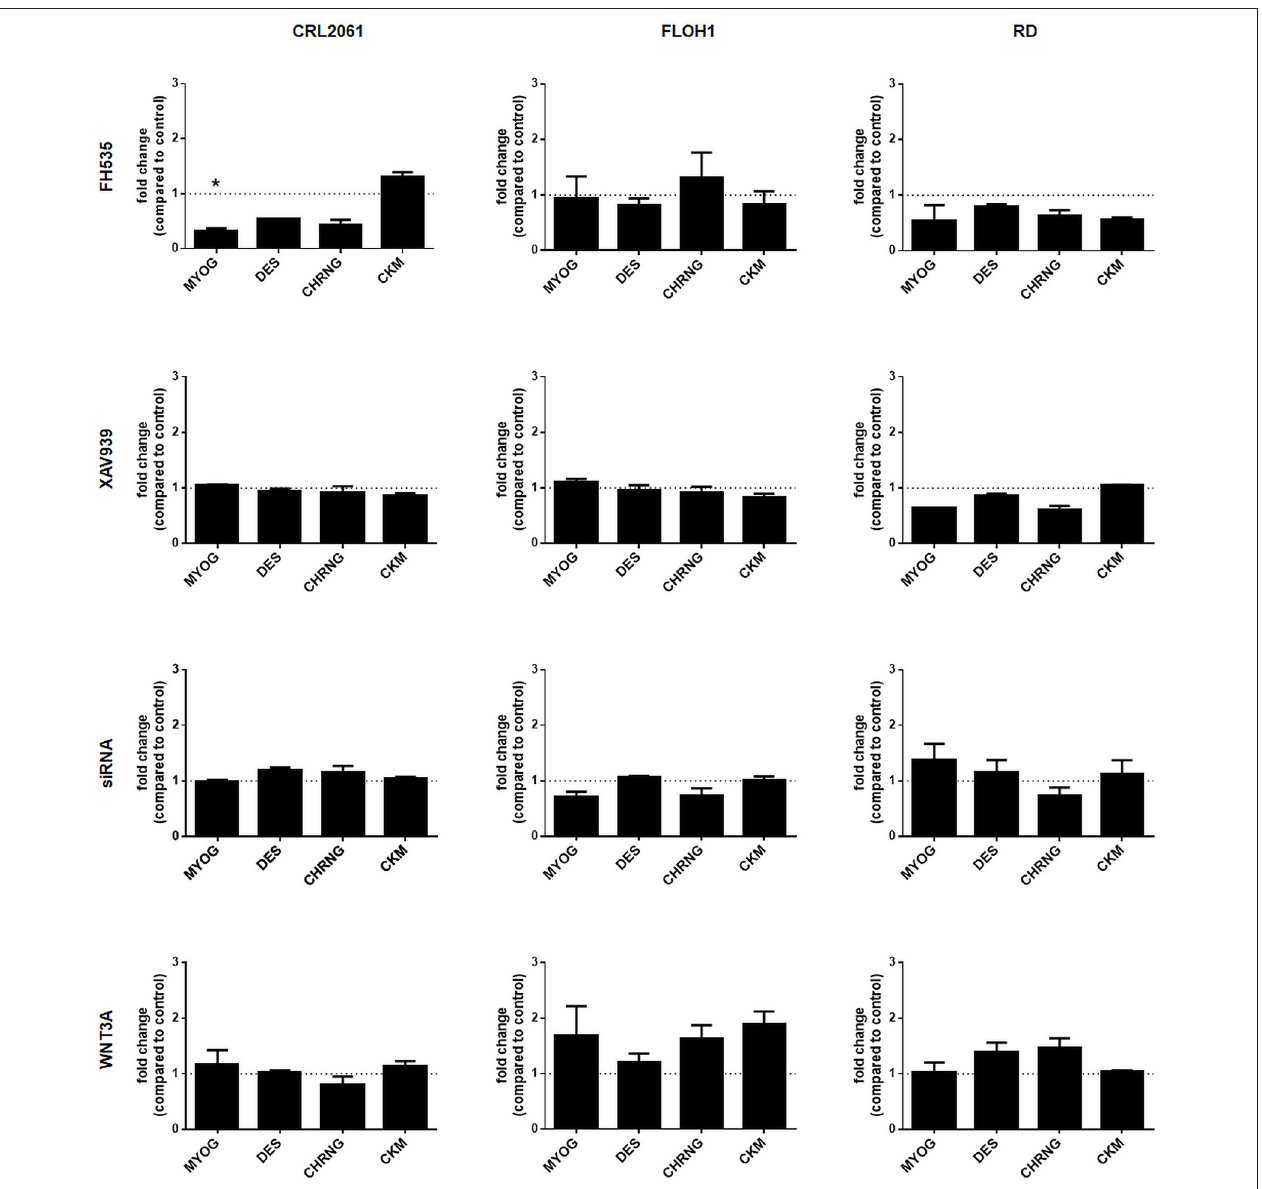
FIGURE 7 | Effects of FH535, XAV939, ß-catenin-siRNA, or WNT3A on the expression of muscle differentiation genes. qRT-PCR of muscle differentiation genes after treatment with FH535, XAV939, ß-catenin siRNA, or WNT3A for 48h. GAPDH expression was used for normalization. Shown is the mean and SEM of three independent experiments measured in duplicates. MYOG, myogenin; DES, desmin; CHRNG, acetylcholine receptor gamma subunit; CKM, creatine kinase muscle. Significance level: * p < 0.05.